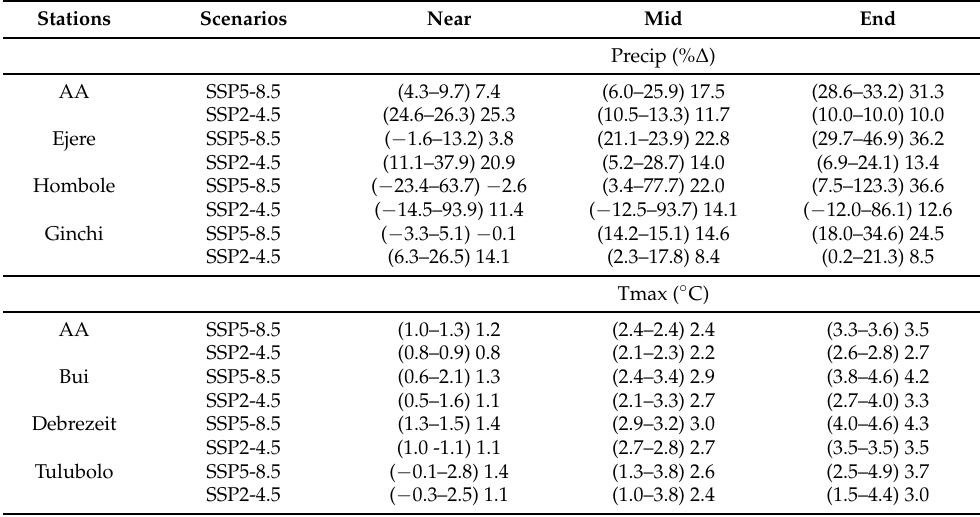
Table 10. Mean annual future climate change at the selected four meteorological stations in the UASB for the three time periods and two